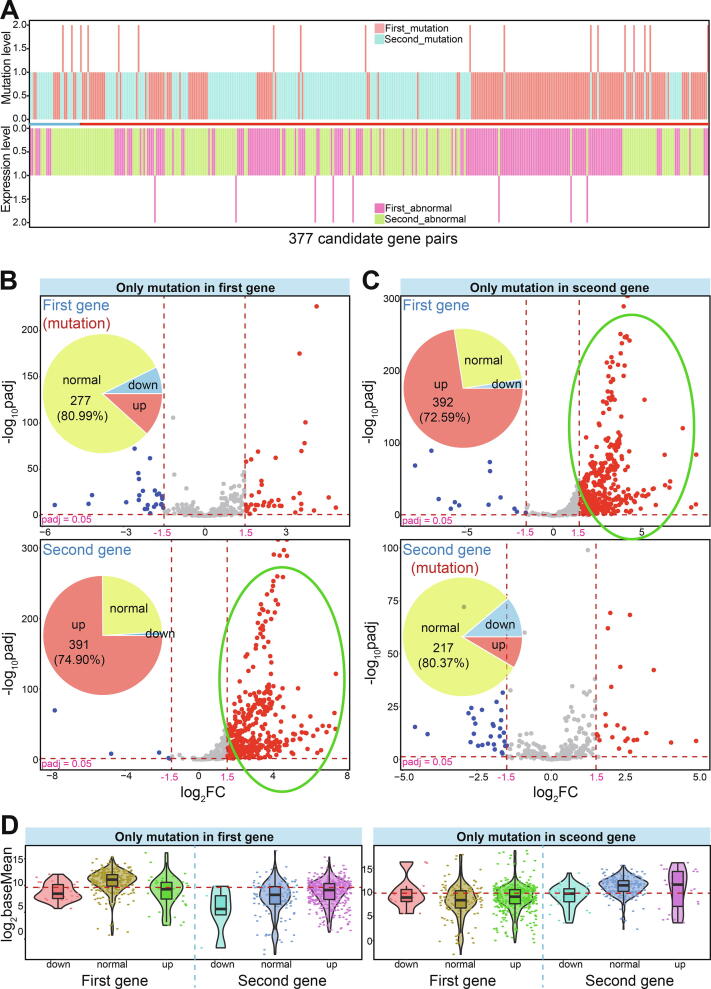
Screening candidate gene pairs based on both mutation and expression levels. A. The detailed mutation and expression patterns based on 377 candidate gene pairs containing at least one mutated gene (the up picture) or abnormally expressed gene (the below picture). Mutated gene is identified if it is detected at least in 5 cancer types, and abnormally expressed gene is identified if it is deregulated in more than 10 cancer types. First and second genes indicates the relative positions in paired genes. B. Scatter plots indicate expression patterns of involved genes across diverse cancer types based on further screened paired genes (first gene is involved in mutation). The pie distributions for deregulated numbers are also presented. The specific values are presented using dotted lines. C. Scatter plots indicate expression patterns of involved genes across diverse cancer types based on further screened paired genes (second gene is involved in mutation). The pie distributions for deregulated numbers are also presented. The specific values are presented using dotted lines. D. The expression patterns of different gene classes based on baseMean values according to Fig. 5B and C. The detailed dots show the baseMean values in diverse cancer types. The median value of log2baseMean for all relevant genes is presented.